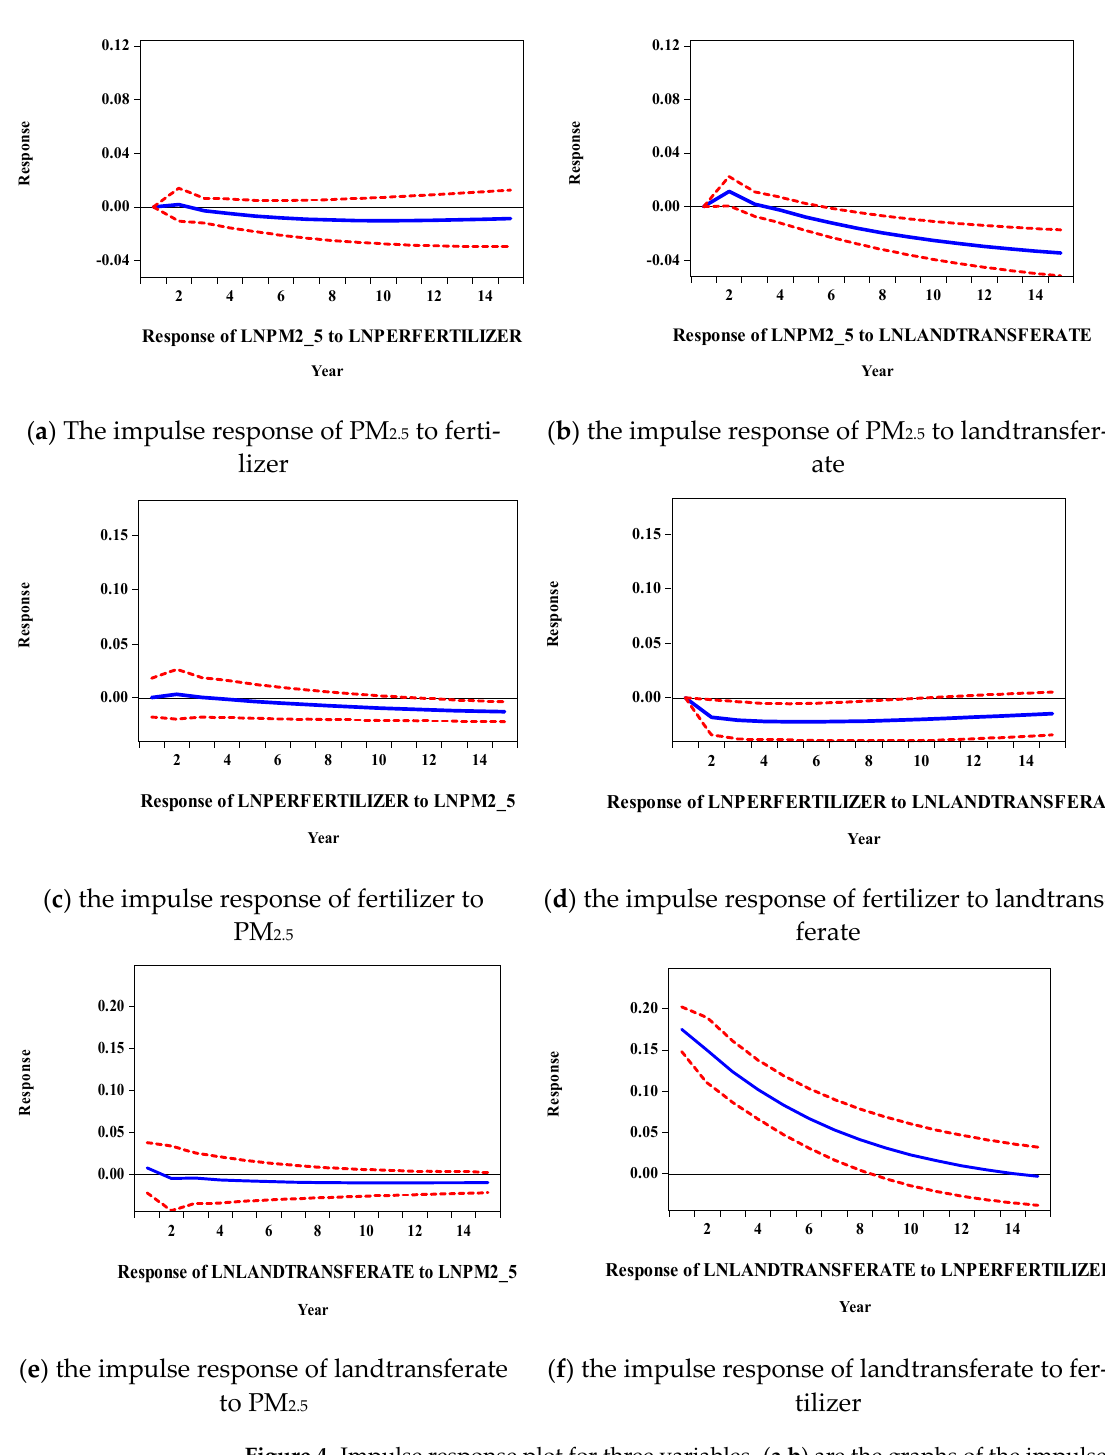
Figure 4. Impulse response plot for three variables. ( a , b ) are the graphs of the impulse response of PM 2.5 to fertilizer and landtransferate, ( c , d ) are the graph of the impulse response of fertilizer to PM 2.5 and landtransferate, ( e , f ) are the graph of the impulse response of landtransferate to PM 2.5 and fertilizer. Note: red lines represent the upper and lower lines of the 95% confidence interval, blue line represents the impulse response function.